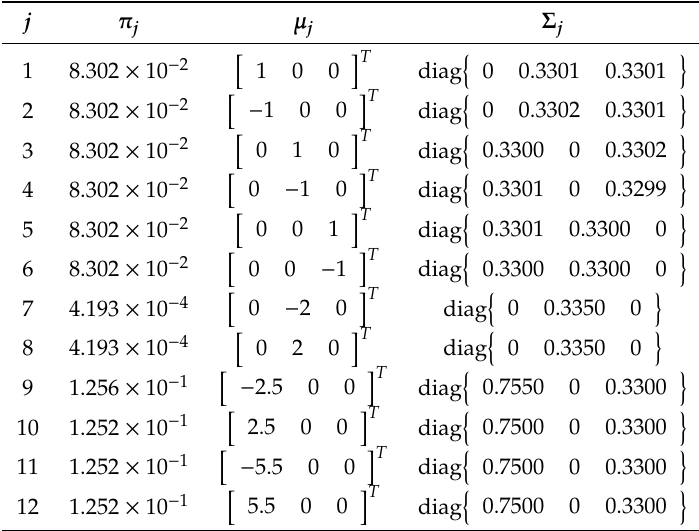
Table 1. The initial key parameters of Gaussian mixture model (GMM).